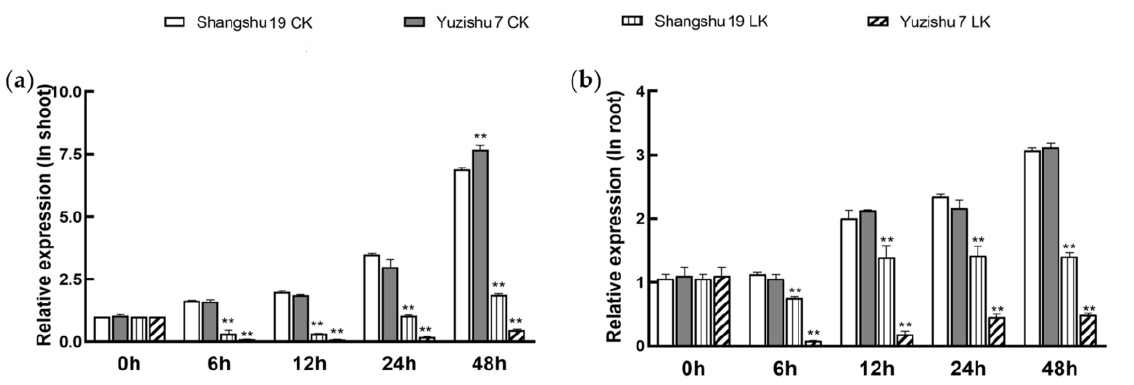
Figure 1. Expression analysis of KIbB1 under normal and low-K + conditions in ( a ) shoots and ( b ) roots. CK means normal condition, and LK means low-K + treatment. Data are presented as means ± SE ( n = 3). ** indicates a significant difference at p < 0.01.